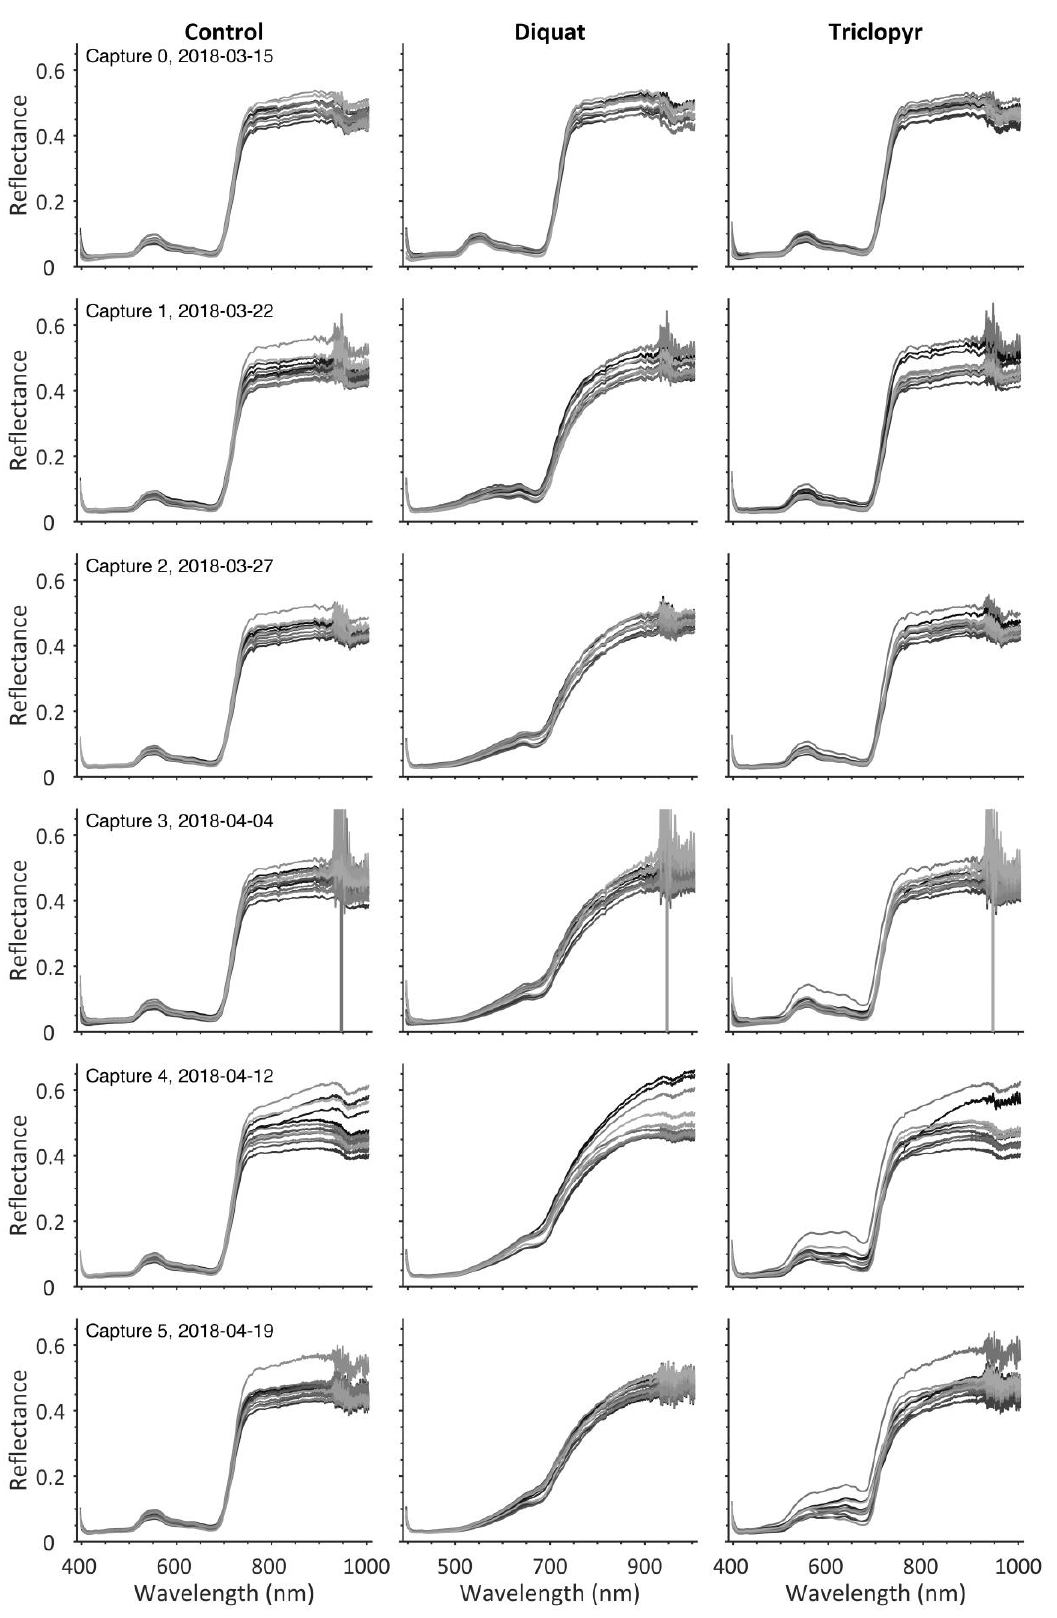
Figure 4. Corrected spectra of all trees. The left column contains the control group, the middle and right columns show the spectra of trees treated with herbicides.